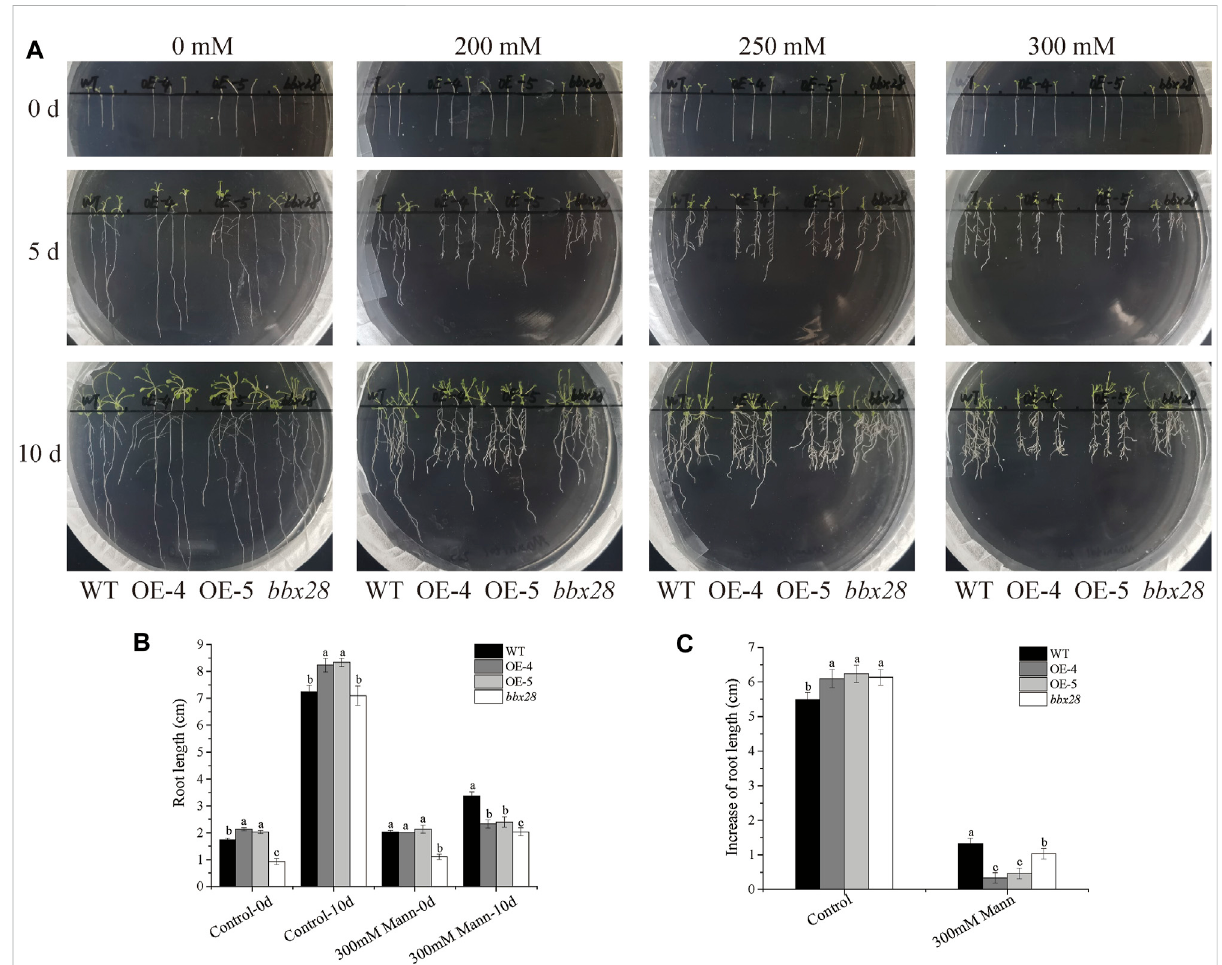
FIGURE 3 The phenotype of overexpressing IbBBX28 transgenic Arabidopsis and bbx28 T-DNA insertion Arabidopsis in 1/2MS medium supplemented withdifferentconcentrationsofmannitol. (A) Thegrowthofoverexpressing IbBBX28 transgenicArabidopsisin1/2MSmediumsupplementedwith0, 200, 250, and 300 Mm mannitol. (B) The root length. (C) The root elongation. Data are presented as means ± SD ( n = 3). Different lowercase letters indicate signi fi cant differences between OE-4, OE-5, bbx28 , and WT ( p < 0.05) by one-way ANOVA and least signi fi cant difference (LSD)